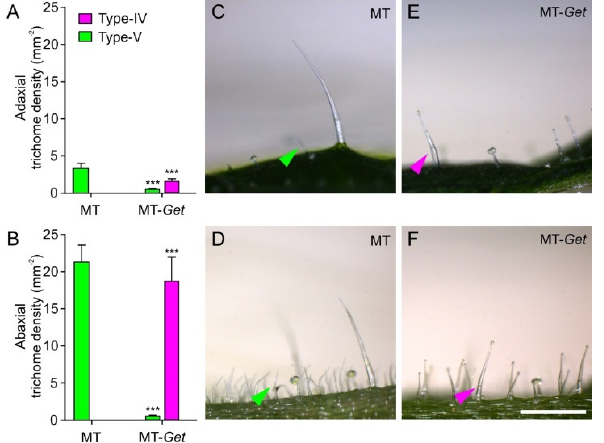
Figure 4. Density (mm − 2 ) of type-IV and -V trichomes on the adaxial ( A ) and abaxial ( B ) sides of the fifth leaves from 45-day-old plants of MT and MT- Get . ( C , D ) Representative micrographs of both sides of the fifth adult leaf from 45-day-old MT plants. ( E , F ) Representative micrographs of both sides of the fifth adult leaf from 45-day-old MT- Get ( F ) plants. Data are means ( n = 40) ± SEM. Asterisks indicate a significant difference when compared with the reference sample according to the Student’s t -test at p < 0.001. (***) Scale bars = 250 µ